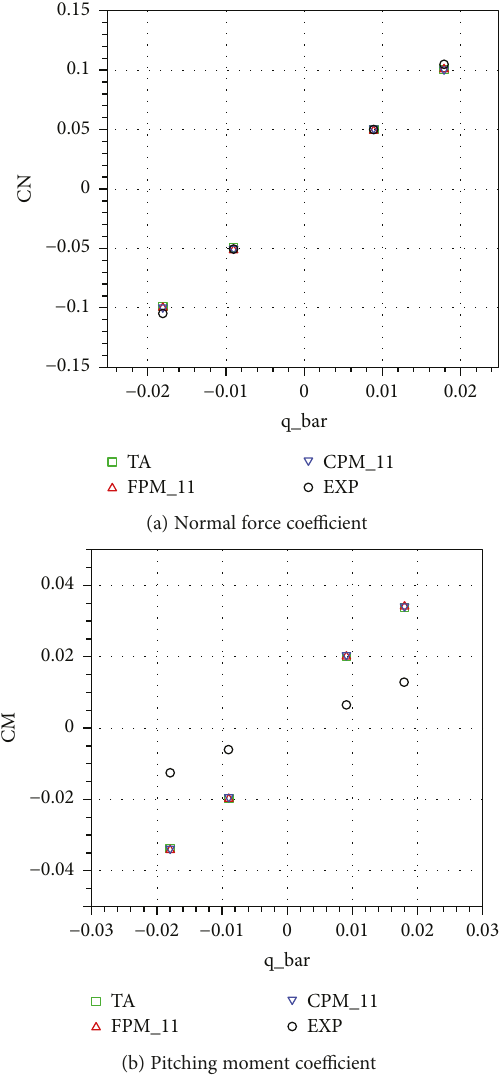
Figure 9: Comparison of normal force and pitching moment coe ffi cient with experimental